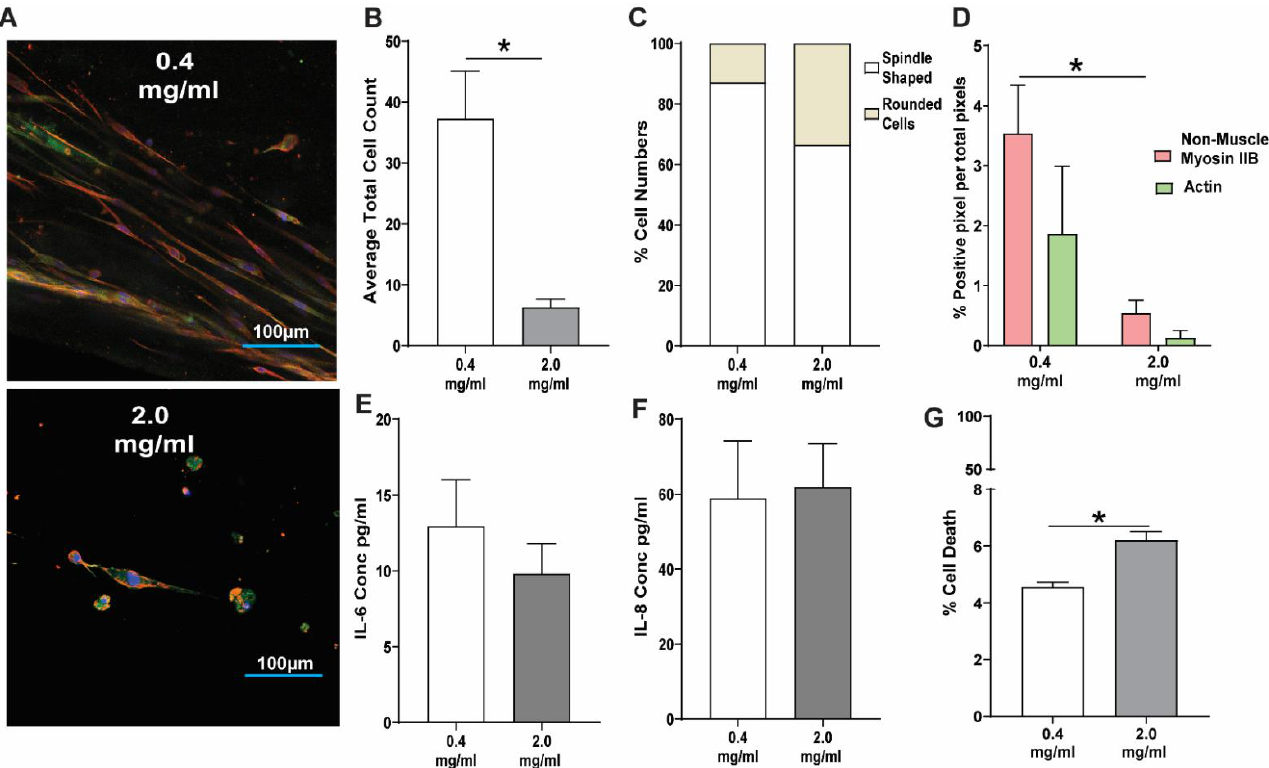
Figure 3. The response of lung fibroblasts to fibrotic collagen-I 3D microenvironment. Human fetal lung 1 (HFL1) fibroblasts were embedded in 3D collagen type-I gels of 0.4 mg/mL and 2.0 mg/mL concentration and cultured for 24 h. Representative confocal image of HFL1s in ( A ) 0.4 mg/mL and ( B ) 2.0 mg/mL collagen-1 gels after culturing for 24 h and staining for non-muscle myosin IIB (red) and F-actin (green). ( C ) Average total cell counts in 0.4 mg/mL and 2.0 mg/mL collagen-I gels. ( D ) Percentage cell numbers of spindle and rounded shaped cells in 0.4 mg/mL and 2.0 mg/mL collagen-I gels. ( E ) Percentage positive pixel count per total number of pixels in images of 0.4 mg/mL and 2.0 mg/mL collagen-I gels. The concentration of ( F ) IL-6 and ( G ) IL-8 cytokines released from HFL1 fibroblasts in 0.4 mg/mL and 2.0 mg/mL collagen-1 gels. ( G ) Percentage cell viability of HFL fibroblasts in 0.4 mg/mL and 2.0 mg/mL collagen-I gels. Mean ± SEM indicated for 3 technical replicates, n = 6. * p <